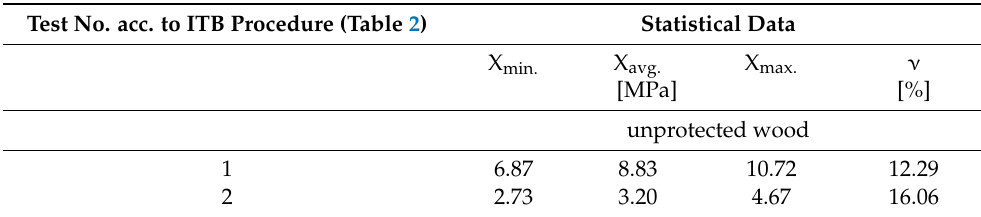
Assumptions Scale Criterion [%]